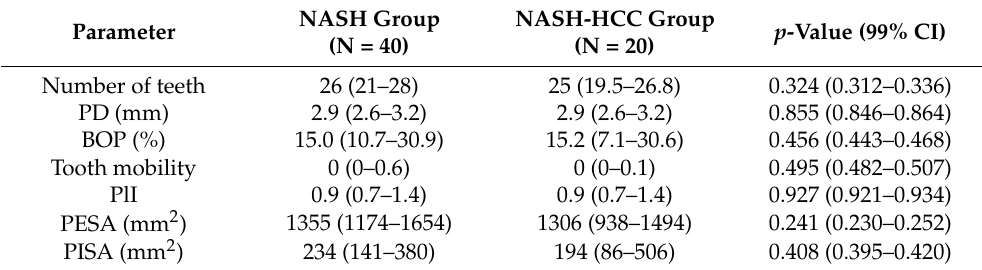
Table 2. Periodontal examinations.